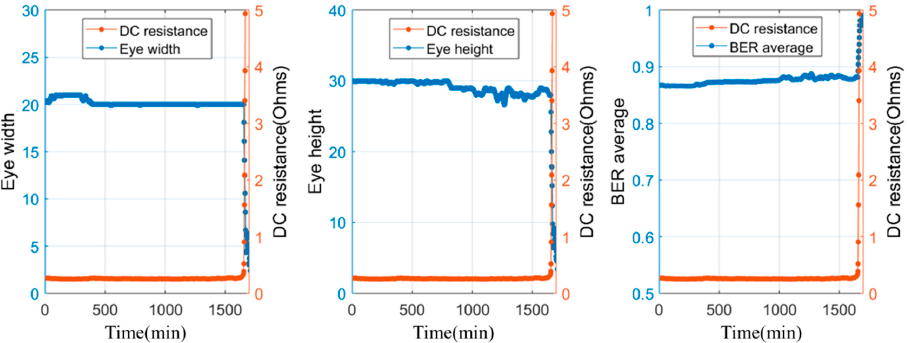
Figure 13. Eye width, eye height, BER average during solder joint corrosion (Test #1).